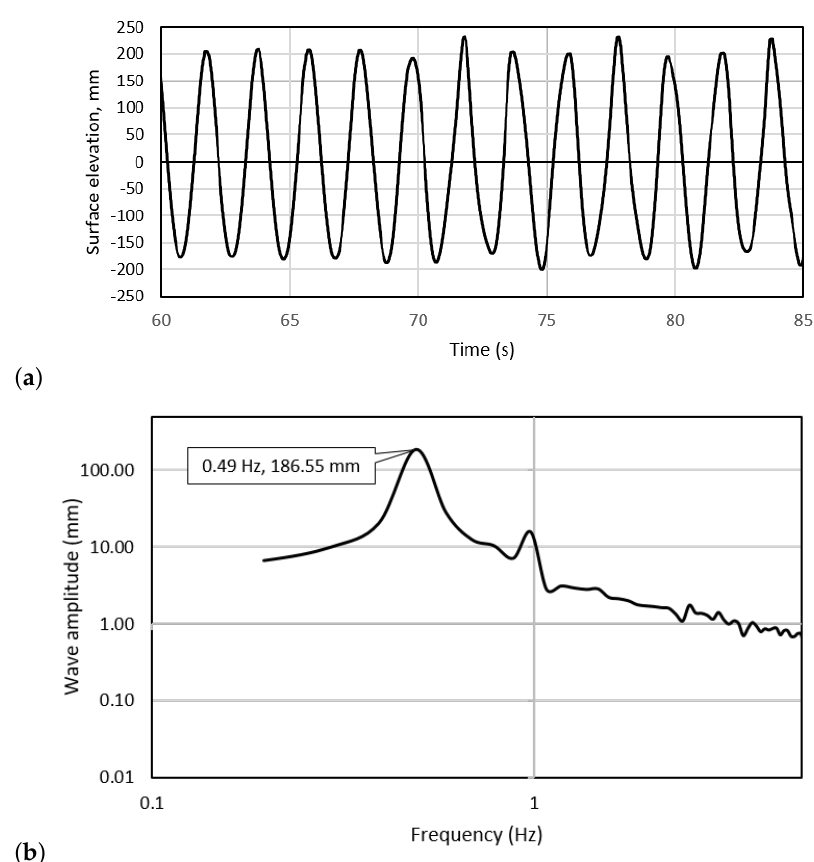
Figure 3. Surface elevation of one of the Extreme wave-tow cases, demonstrating an average wave height of 0.39 m ( a , b ) the frequency spectrum of the signal. For the irregular wave tests, the records were analyzed in the time domain and the zero up-crossing points were selected to define each wave period. Reasonable agreement between the average wave period and wave height was obtained between repeated test runs. However, variations between the repeated records in terms of the maximum and minimum wave periods were noticeable. The average wave period and wave height are also smaller than the programmed significant wave height and peak period, as it can be seen in Table